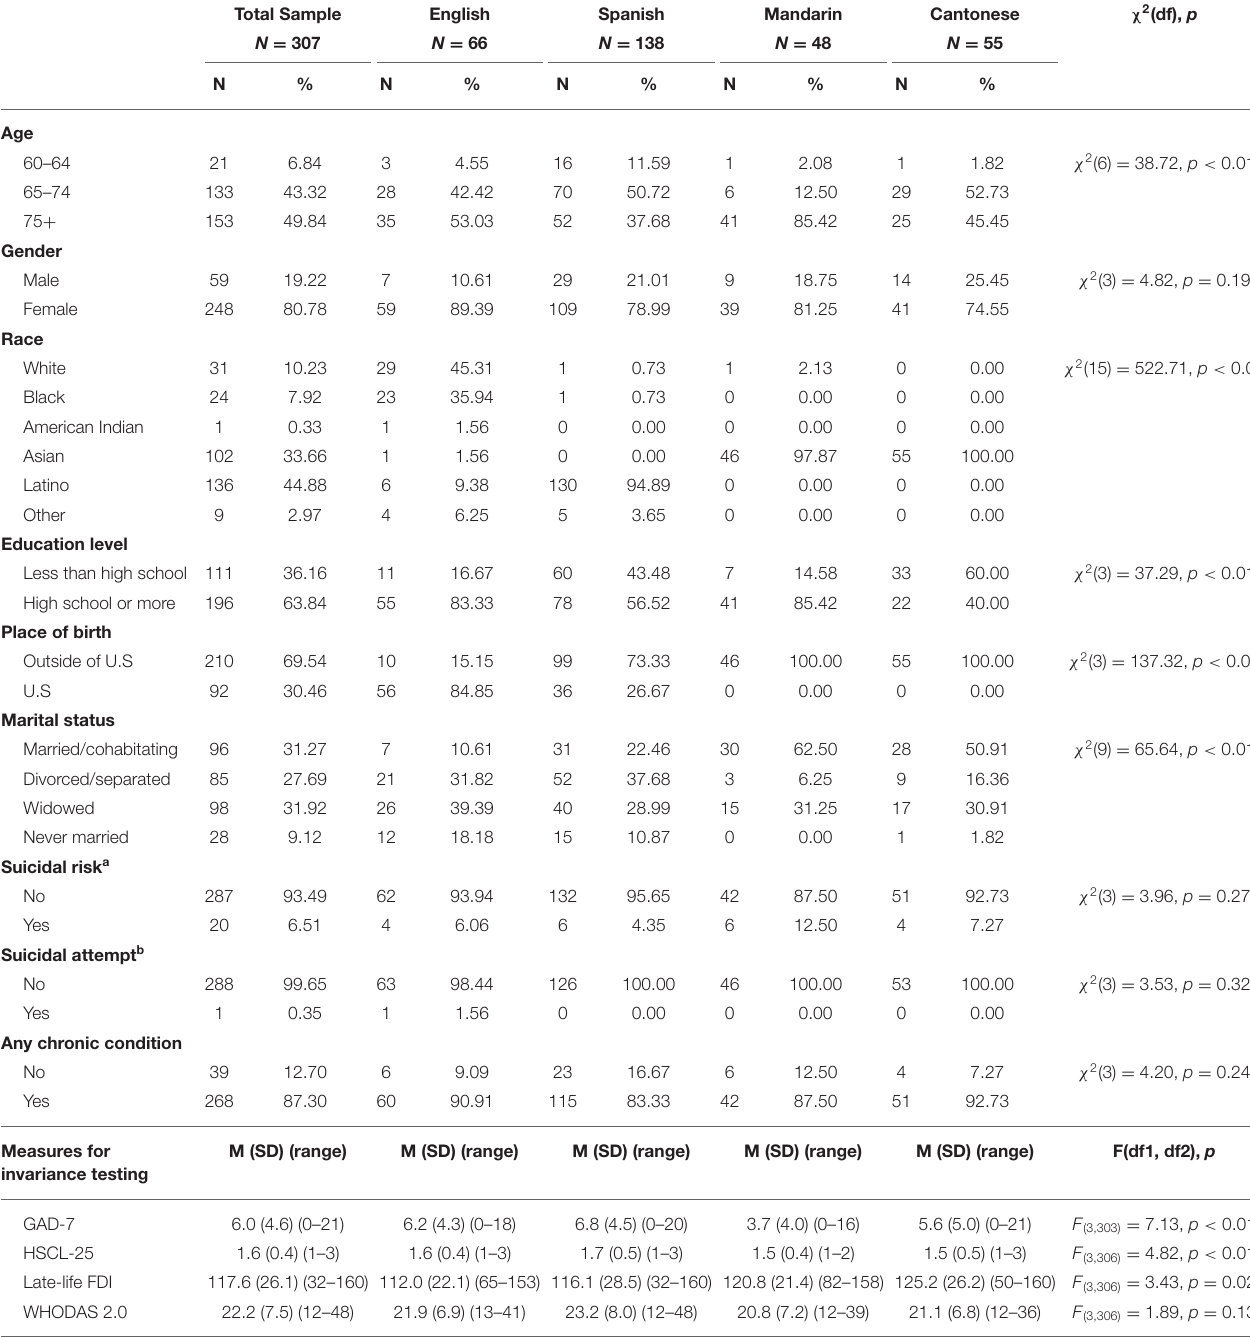
TABLE 1 | Demographic baseline characteristics for the overall sample and by language. Total Sample English Spanish Mandarin Cantonese χ 2 (df),